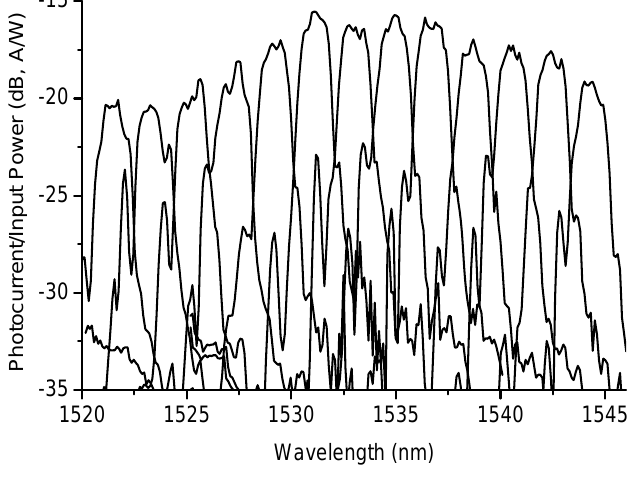
Figure 8. Fiber to detector photocurrent response as a function of wavelengths (detector